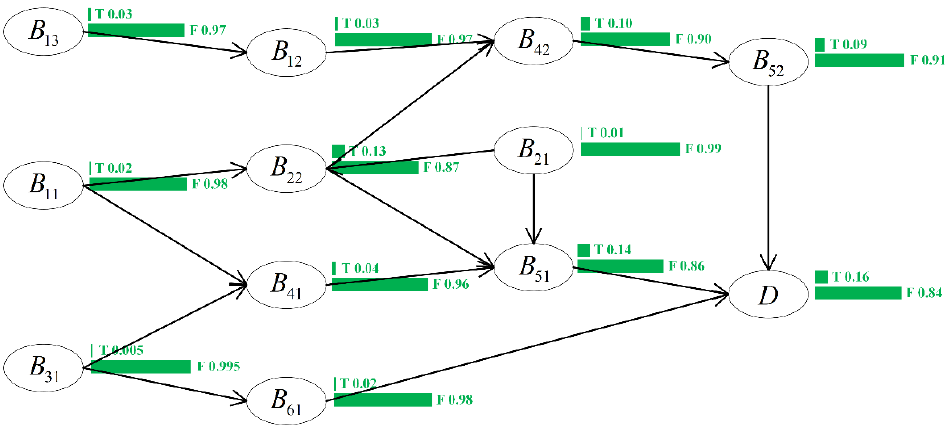
Figure 5. Bayesian network of the risk conduction path. Table 4.